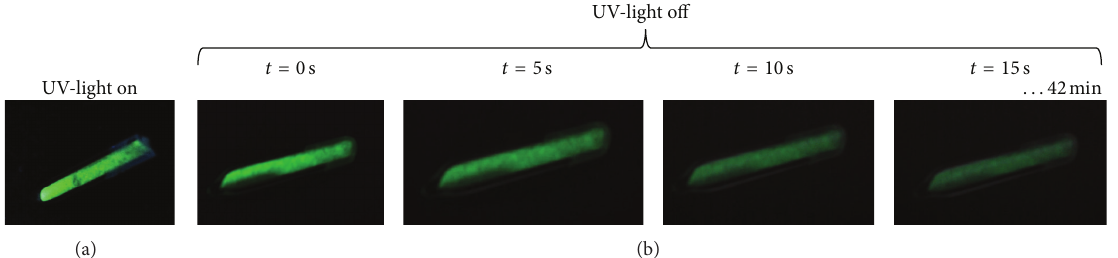
Figure 10: Green luminescence of 5 under UV light (left) and afterglow effect with duration up to 42 minutes after turning the UV light off (right).